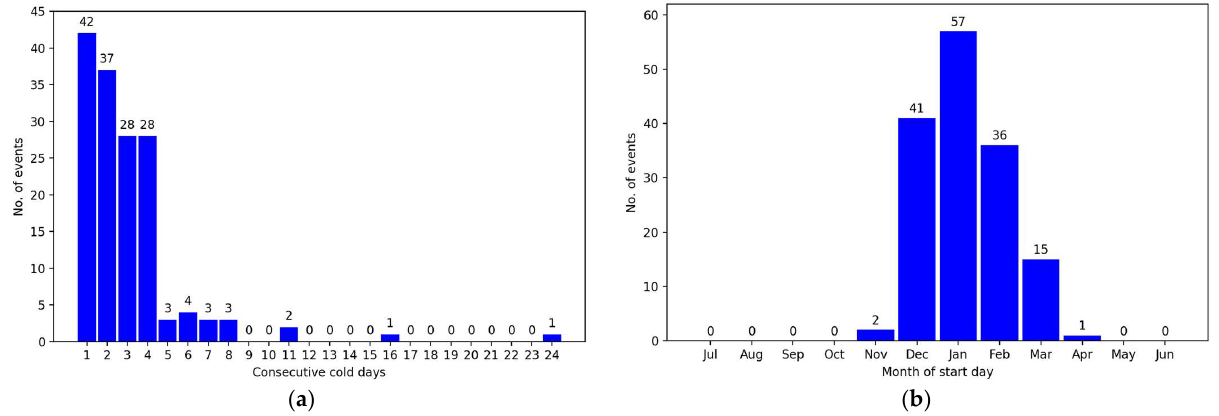
Figure 5. Frequency distributions of cold events against: ( a ) event duration and ( b ) the starting months of cold events during 1991–2020 (total number of events = 152).